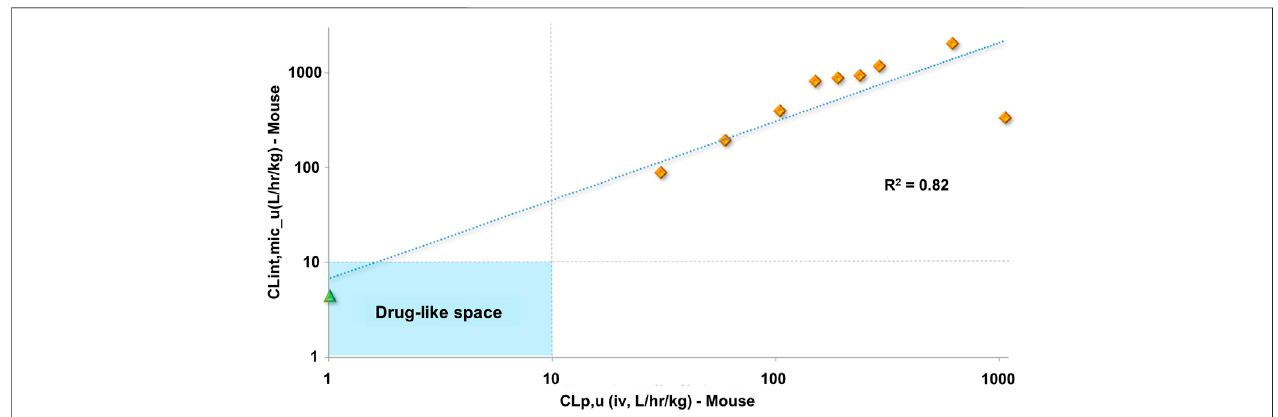
FIGURE 5 | Clearance in vitro-in vivo correlation (IVIVC) plot showing a good correlation between the metabolic stability data. Benznidazole (green triangle); benzimidazole analogs (orange diamonds).